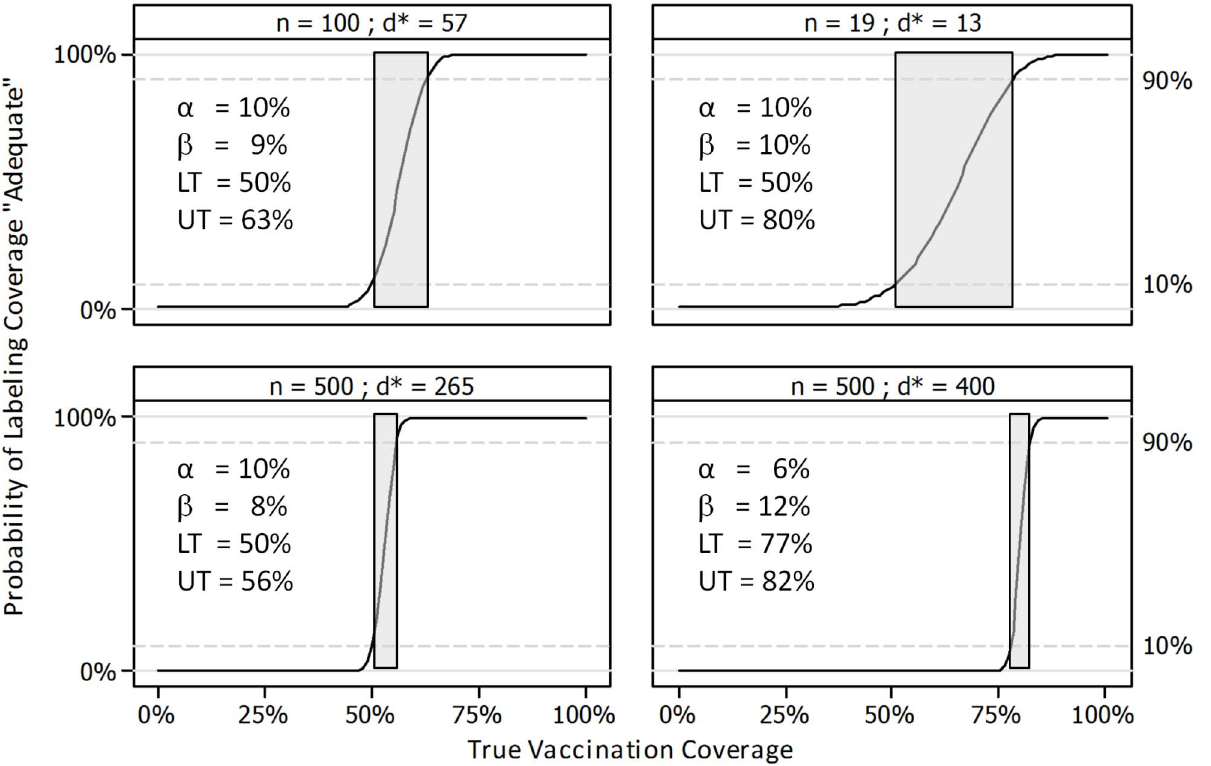
Figure 3. Operating characteristic curves for four LQAS sampling plans. In each panel, the curve indicates the probability of finding d* or more vaccinated children in a random sample of size n . Lots with coverage # lower threshold (LT) will be classified as having inadequate coverage with probability $ (1 2 a ). Lots with coverage $ upper threshold (UT) will be classified as having adequate coverage with probability $ (1 2 b ). The gray area is the region where LT , coverage , UT; lots with coverage in the gray area may be labeled either adequate or inadequate. The gray area includes the region of coverage, for instance, where there is a 50/50 probability of being classified adequate or inadequate. Neither classification (adequate or inadequate) rules out the strong possibility that the true coverage lies in the gray area. The gray area may be made larger or smaller and may be moved to regions of higher or lower coverage by manipulating LT, UT, a , and b to arrive at different values of n and d* .